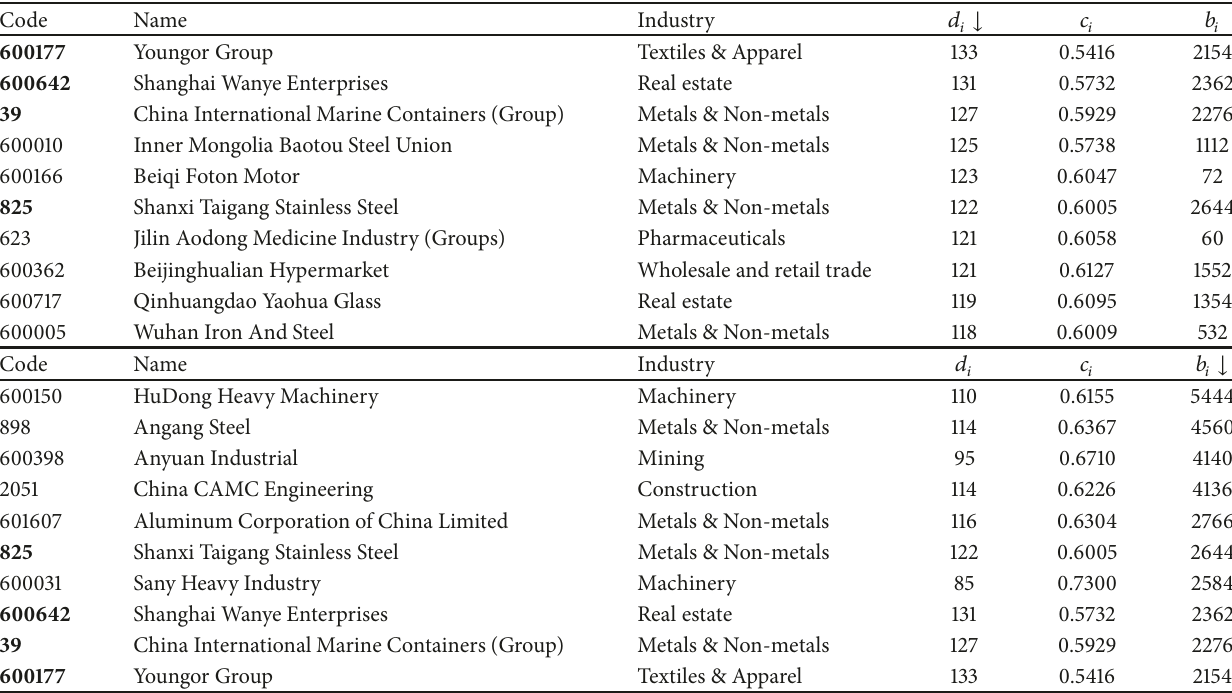
Table 8: Top stocks with highest values of degree 𝑑 𝑖 , and betweenness 𝑏 𝑖 ranked in descending order of 𝑑 𝑖 and 𝑏 𝑖 when the 𝜃 = 0.8 for CSI163 network. Stock codes in bold indicate the stocks appear at both top 10